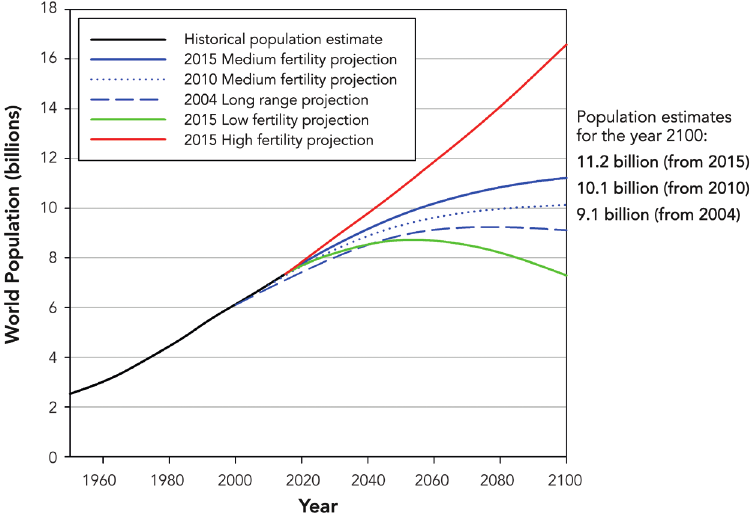
Figure 1. The United Nations population projections, estimated in the 2010 and 2015 revisions (UNDESA 2011). Prior to 2010, the projections in the UN’s World Population Prospects series only extended to 2050, but a long-range forecast in 2004 gave estimates to 2300 (UNDESA